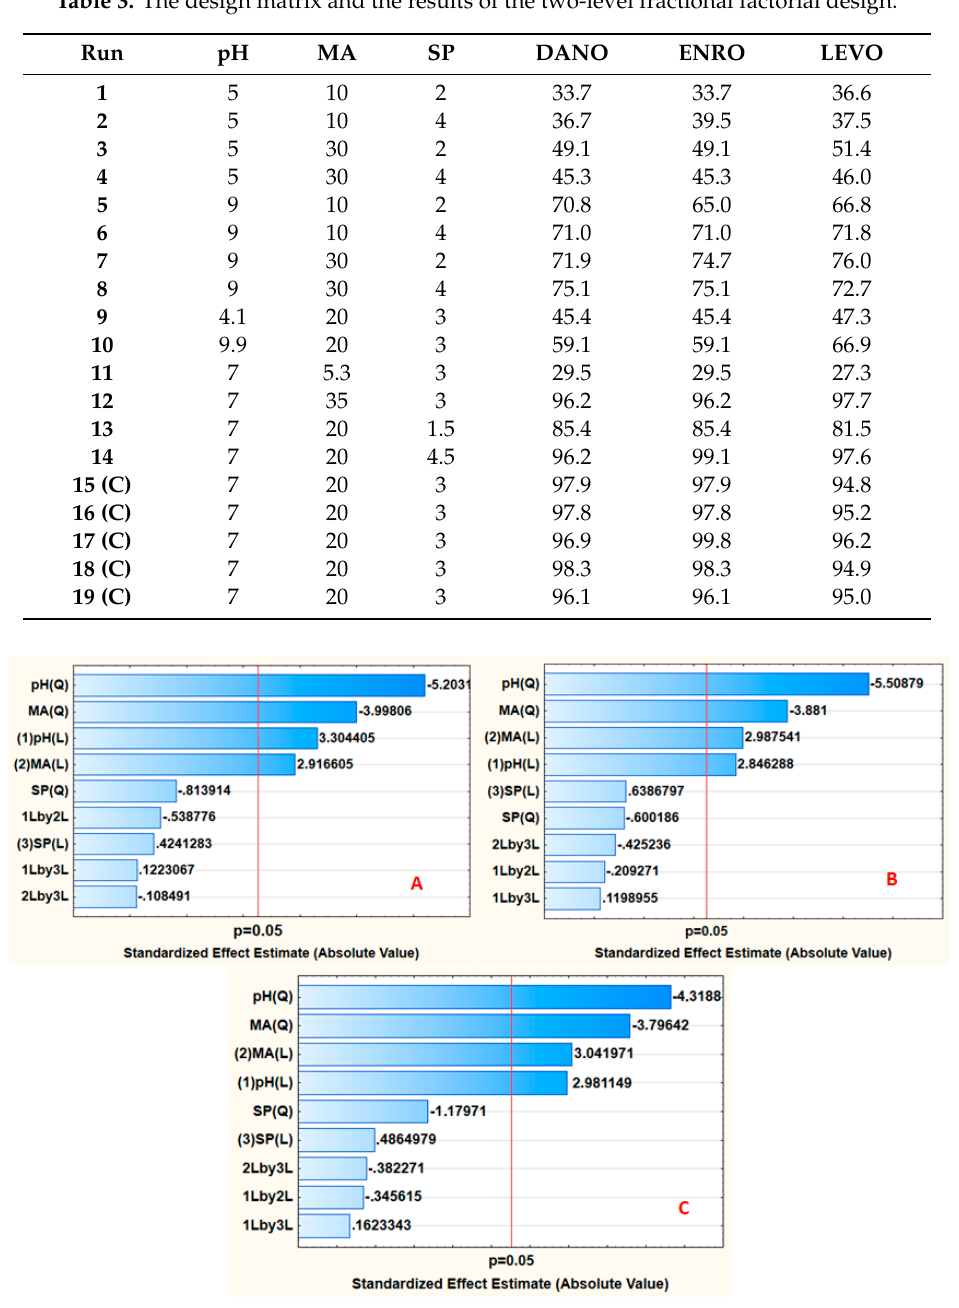
Table 3. The design matrix and the results of the two-level fractional factorial design.